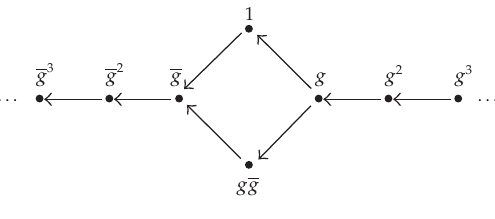
Figure 1: Ext quiver of W (cid:4) n 1 ,n 2 ,n 3 (cid:5) .